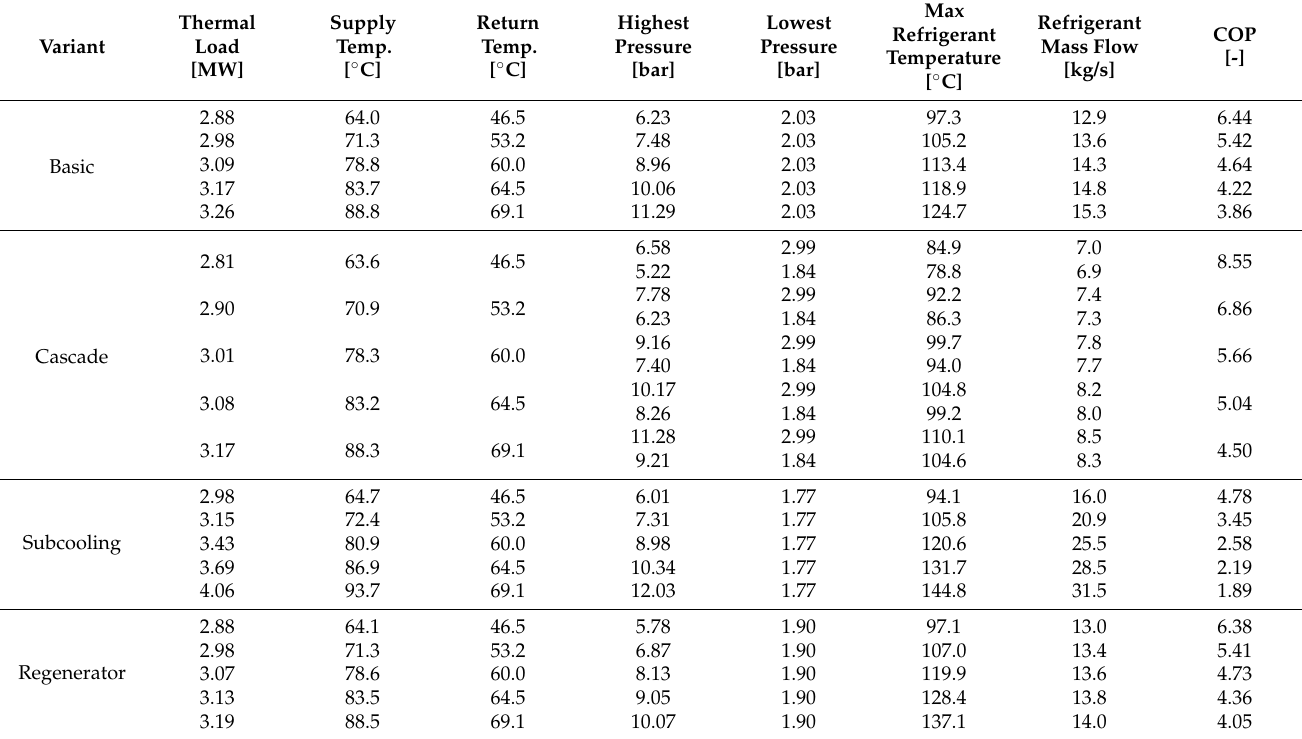
Table 2. Cycle parameters of all calculated models.